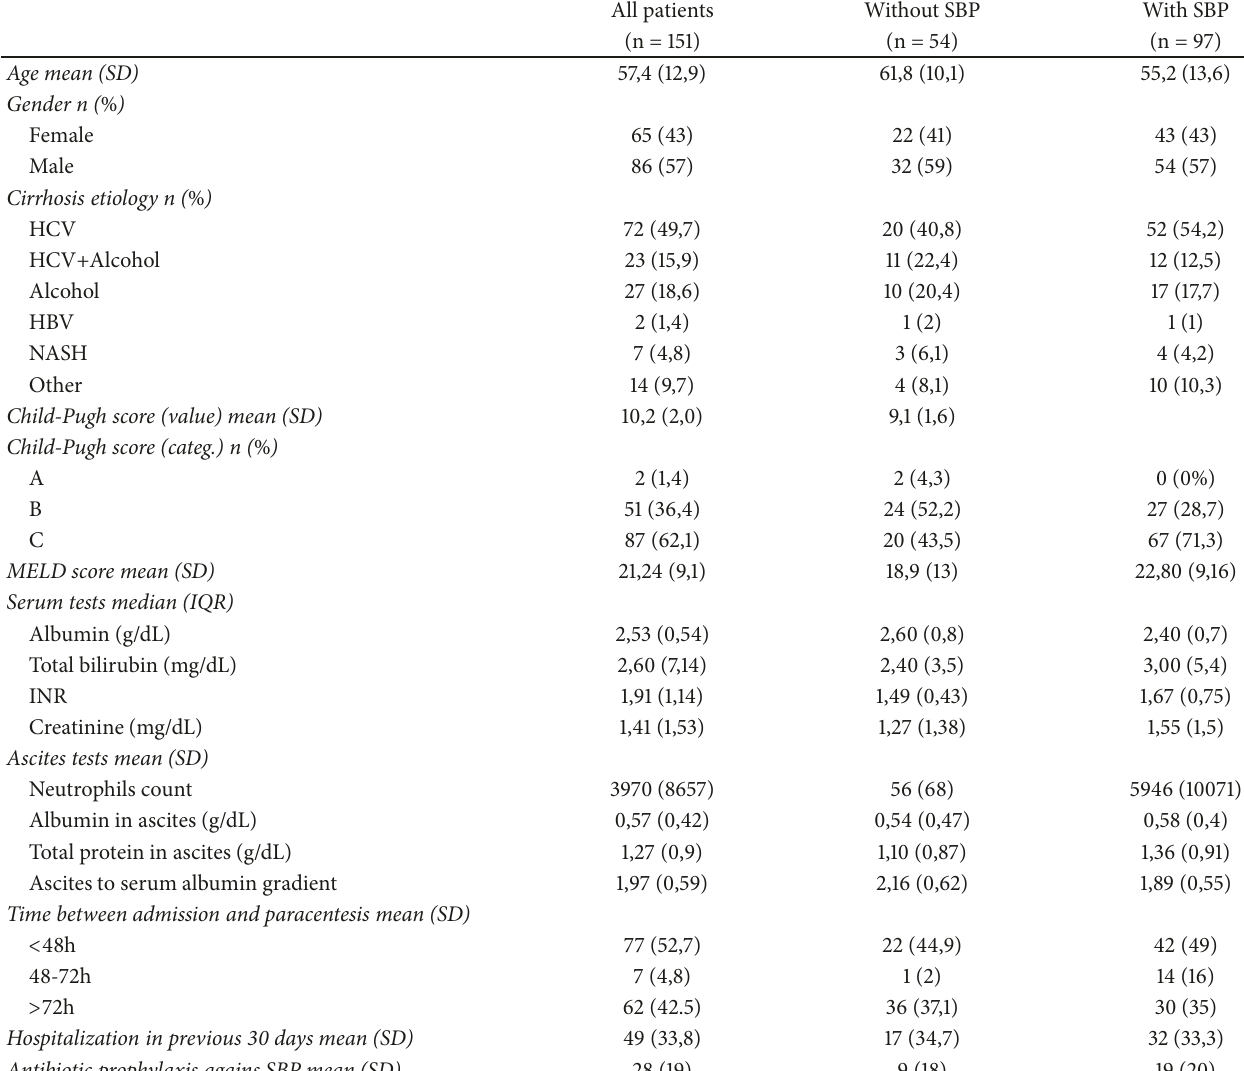
Table 1: Demographic and clinical characteristics of patients. All